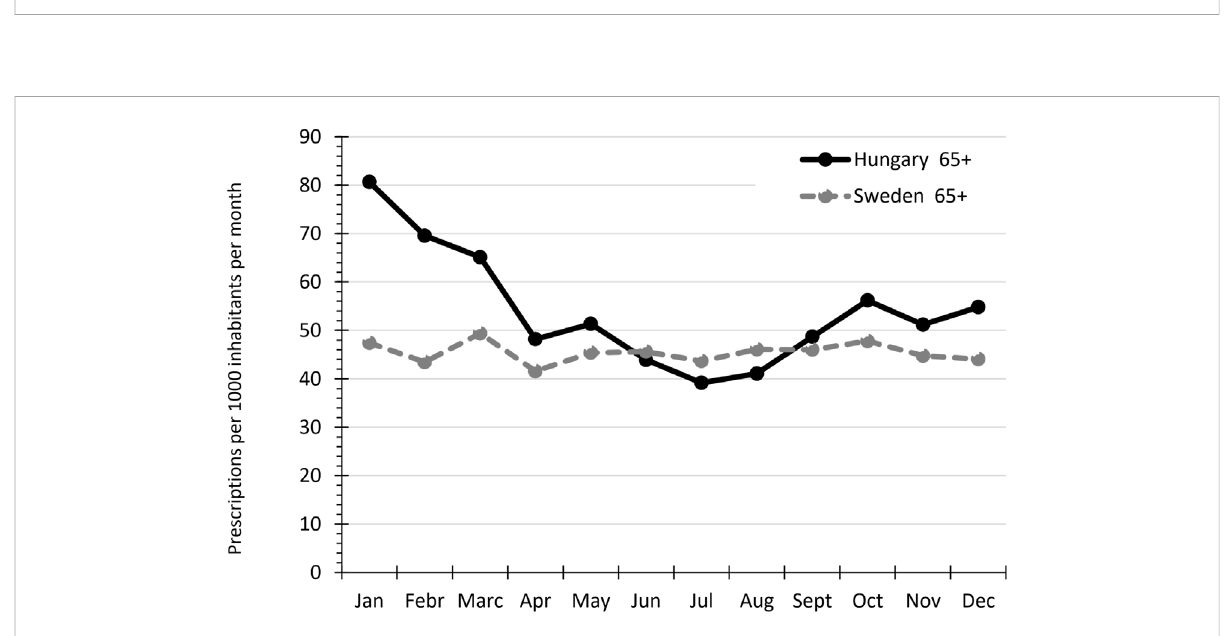
FIGURE 3 Seasonal variation of antibiotic use among the elderly population in Hungary and Sweden in